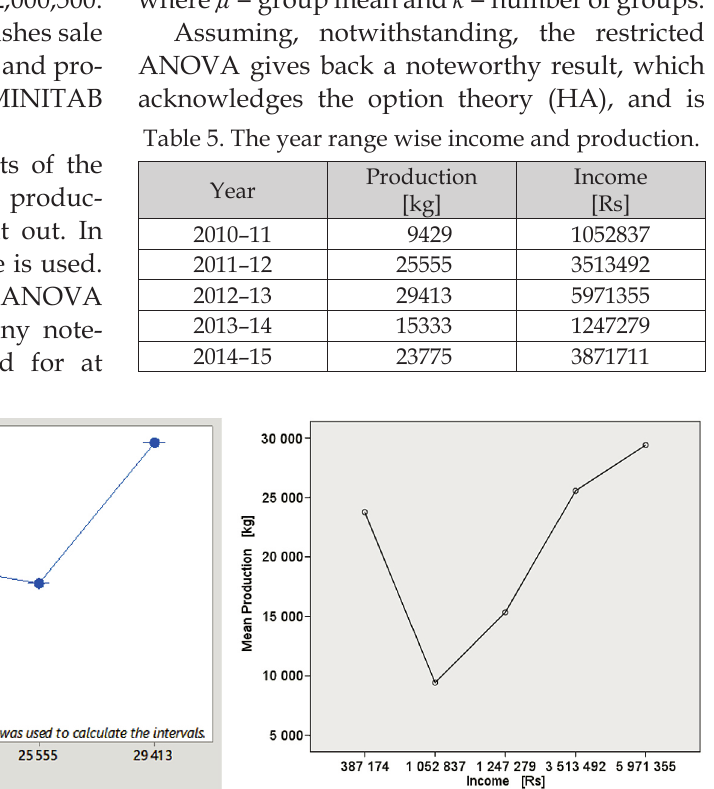
Fig. 7. Charts show the relation between income and production year